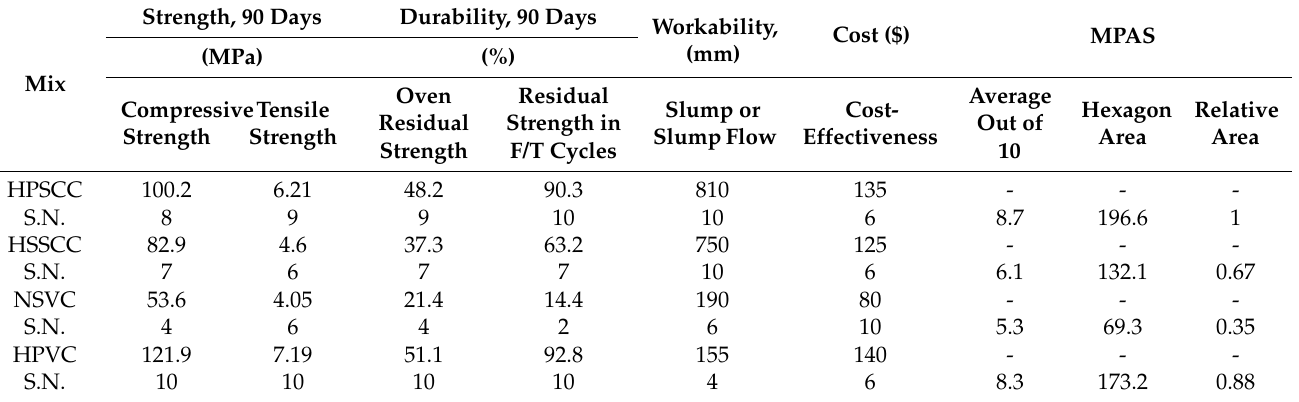
Table 11. Comparison scales and rating for the four concrete mixes.